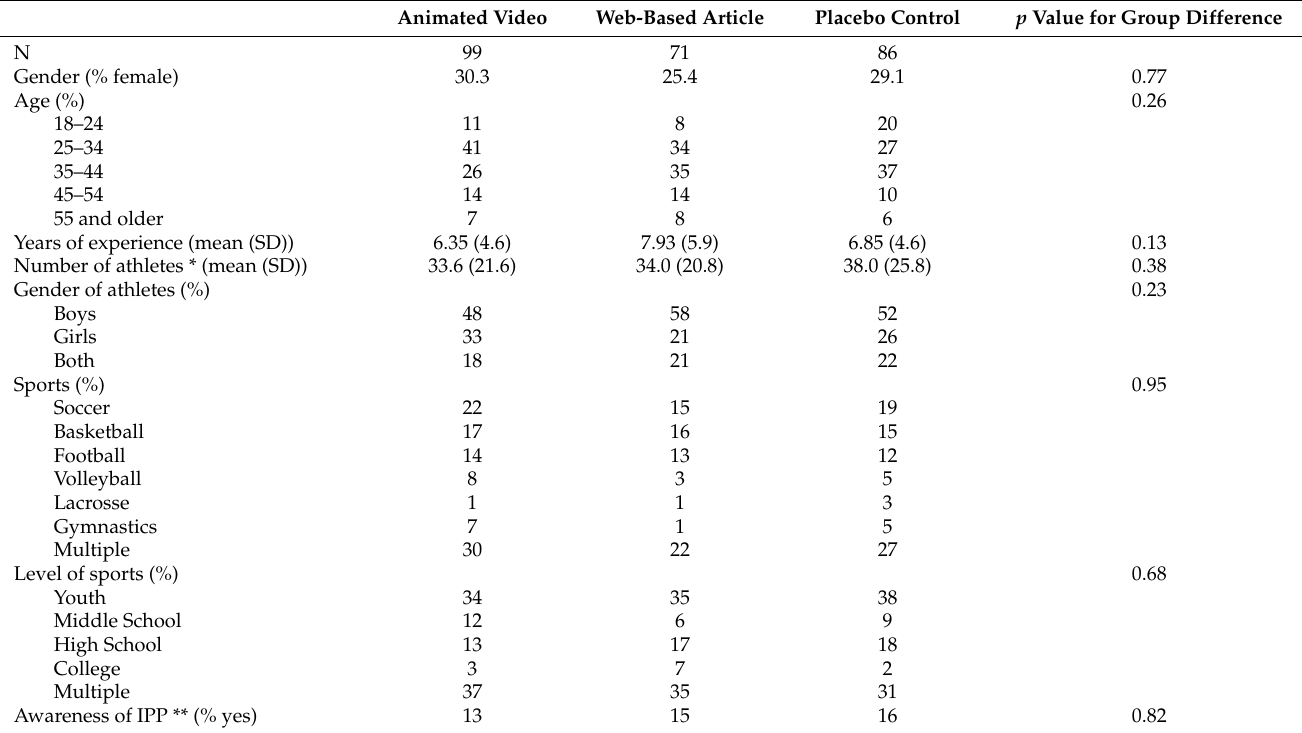
Table 1. Demographic characteristics.